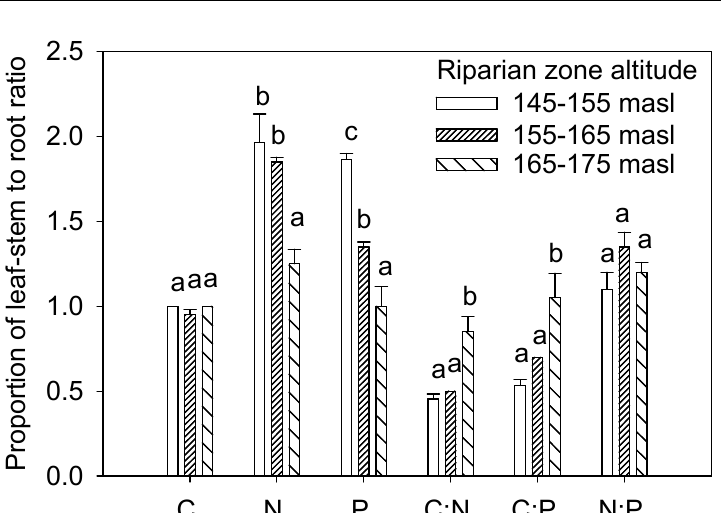
Figure 5. C:N:P stoichiometry with NPP . Leaf-stem: ( a1 – f1 ), Root: ( a2 – f2 ), leaf-stem/root: ( a3 – f3 ). 3.4. Exploring the Indicators of NPP SEM analysis showed that the C:P ratio in the root (C:P root ) and the proportion of C:N ratio in leaf-stem and root (C:N leaf-stem/root ) had a direct effect, while submerging stress and the proportion of N in leaf-stem and root (N leaf-stem/root ) exerted an indirect effect on the NPP. All of these variables predicted 68% of the variance in the NPP (Figure 6a). Specifically, flooding stress had a direct